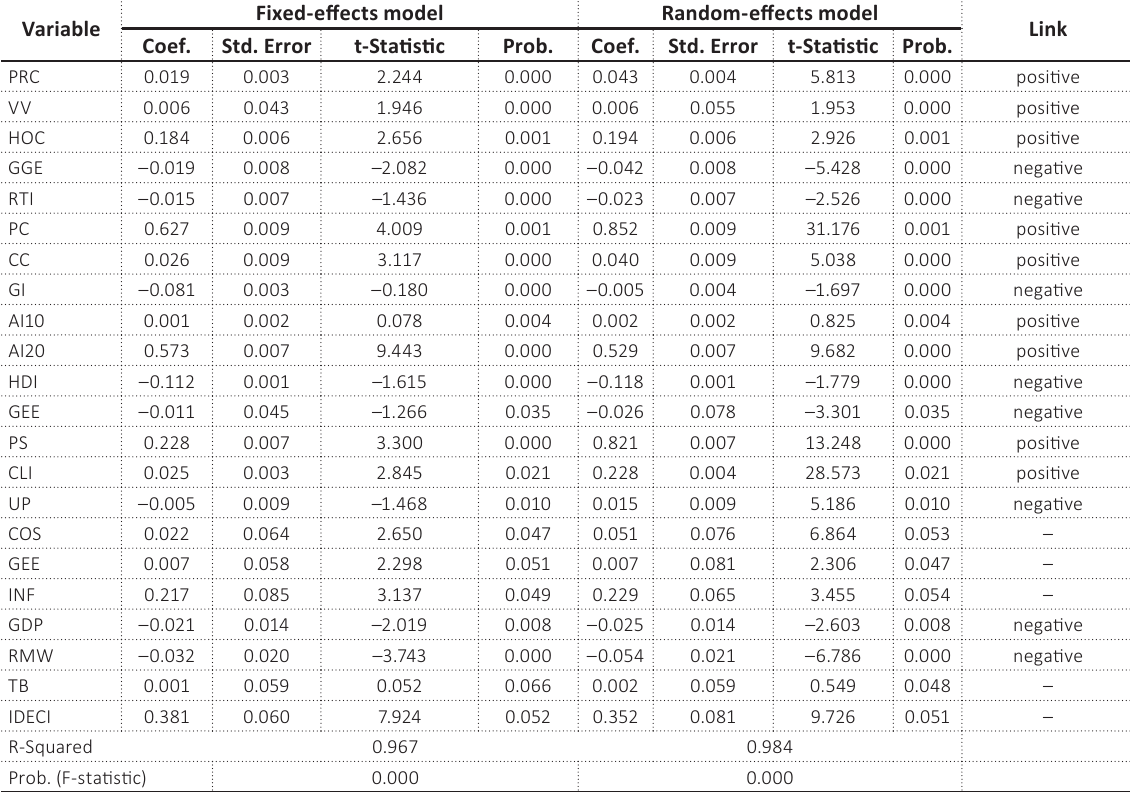
Table 1. Variance analysis for four clusters